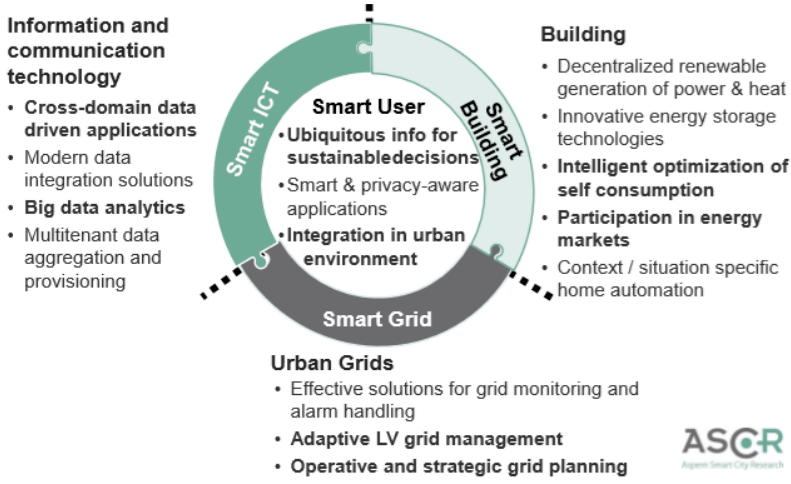
Figure 2. The fundamentals of future Smart Cities, [35].